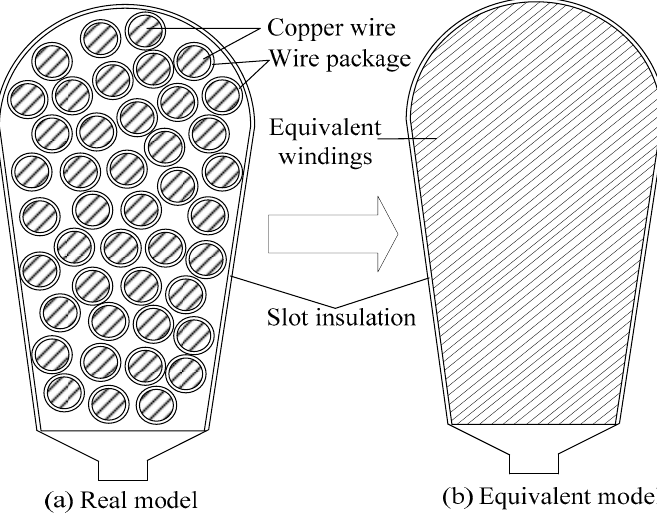
Figure 7. Equivalent model of the armature windings in one slot, ( a ) real model of windings in stator slot; and, ( b ) equivalent model of windings in stator slot.